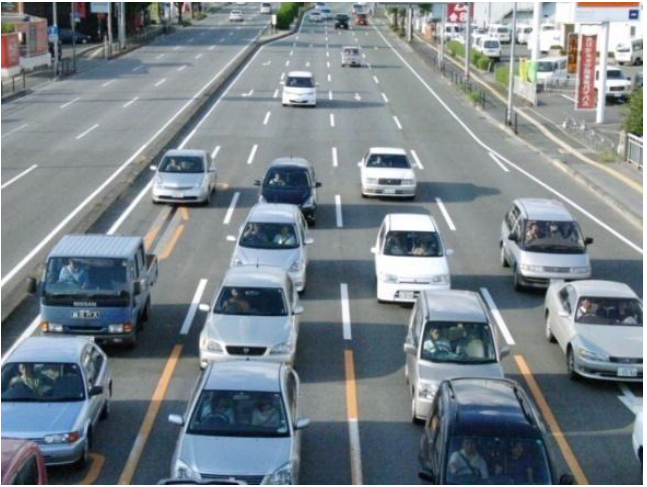
Figure 7. One frame of the visible light images taken in